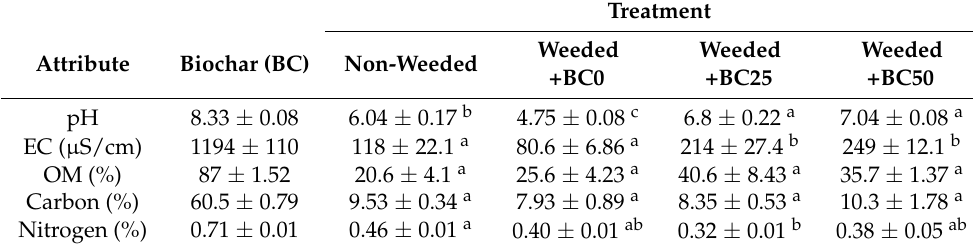
Table 1. Properties of soil samples and biochar used in the experiment. Values were based on 3 samples for biochar and 5 samples for each soil treatment (one per plot replicate). Mean values are listed as ± 1 SE; soil treatment differences significant at p < 0.05 (Tukey HSD post hoc tests) are indicated by different